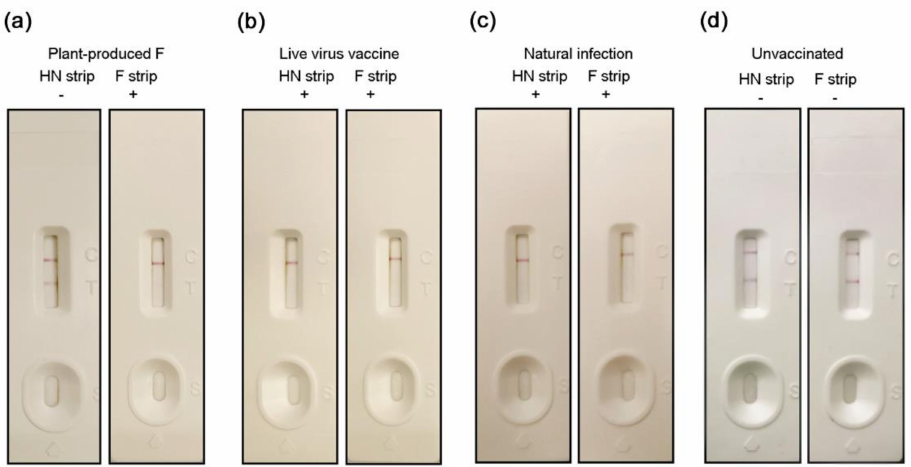
Figure 7. Distinction between infected and vaccinated animals. The specific antibodies that recognize HN and F proteins were detected by immunochromatographic strips. ( a ) Serum from chickens vaccinated with plant-produced F. ( b ) Serum from chickens vaccinated with ND live virus vaccine. ( c ) Serum from chickens infected with NDV. ( d ) Serum from unvaccinated and uninfected chickens.Two lines represent negative and one line represents